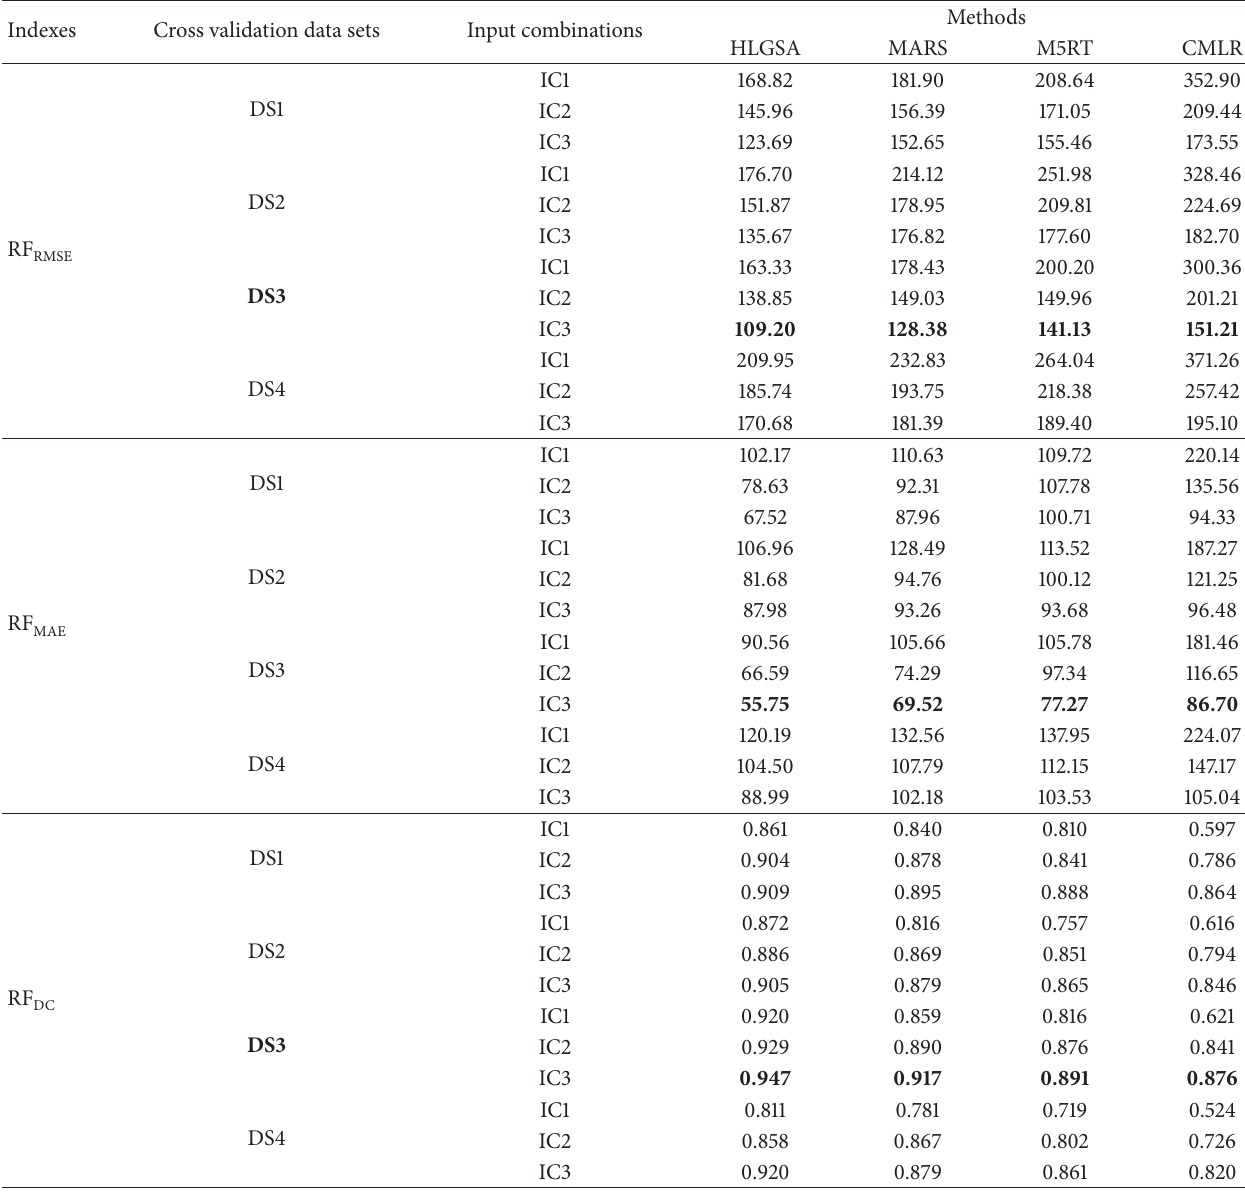
Table 3: Comparison of the HLGSA, MARS, M5RT, and CMLR methods: Shyok catchment.